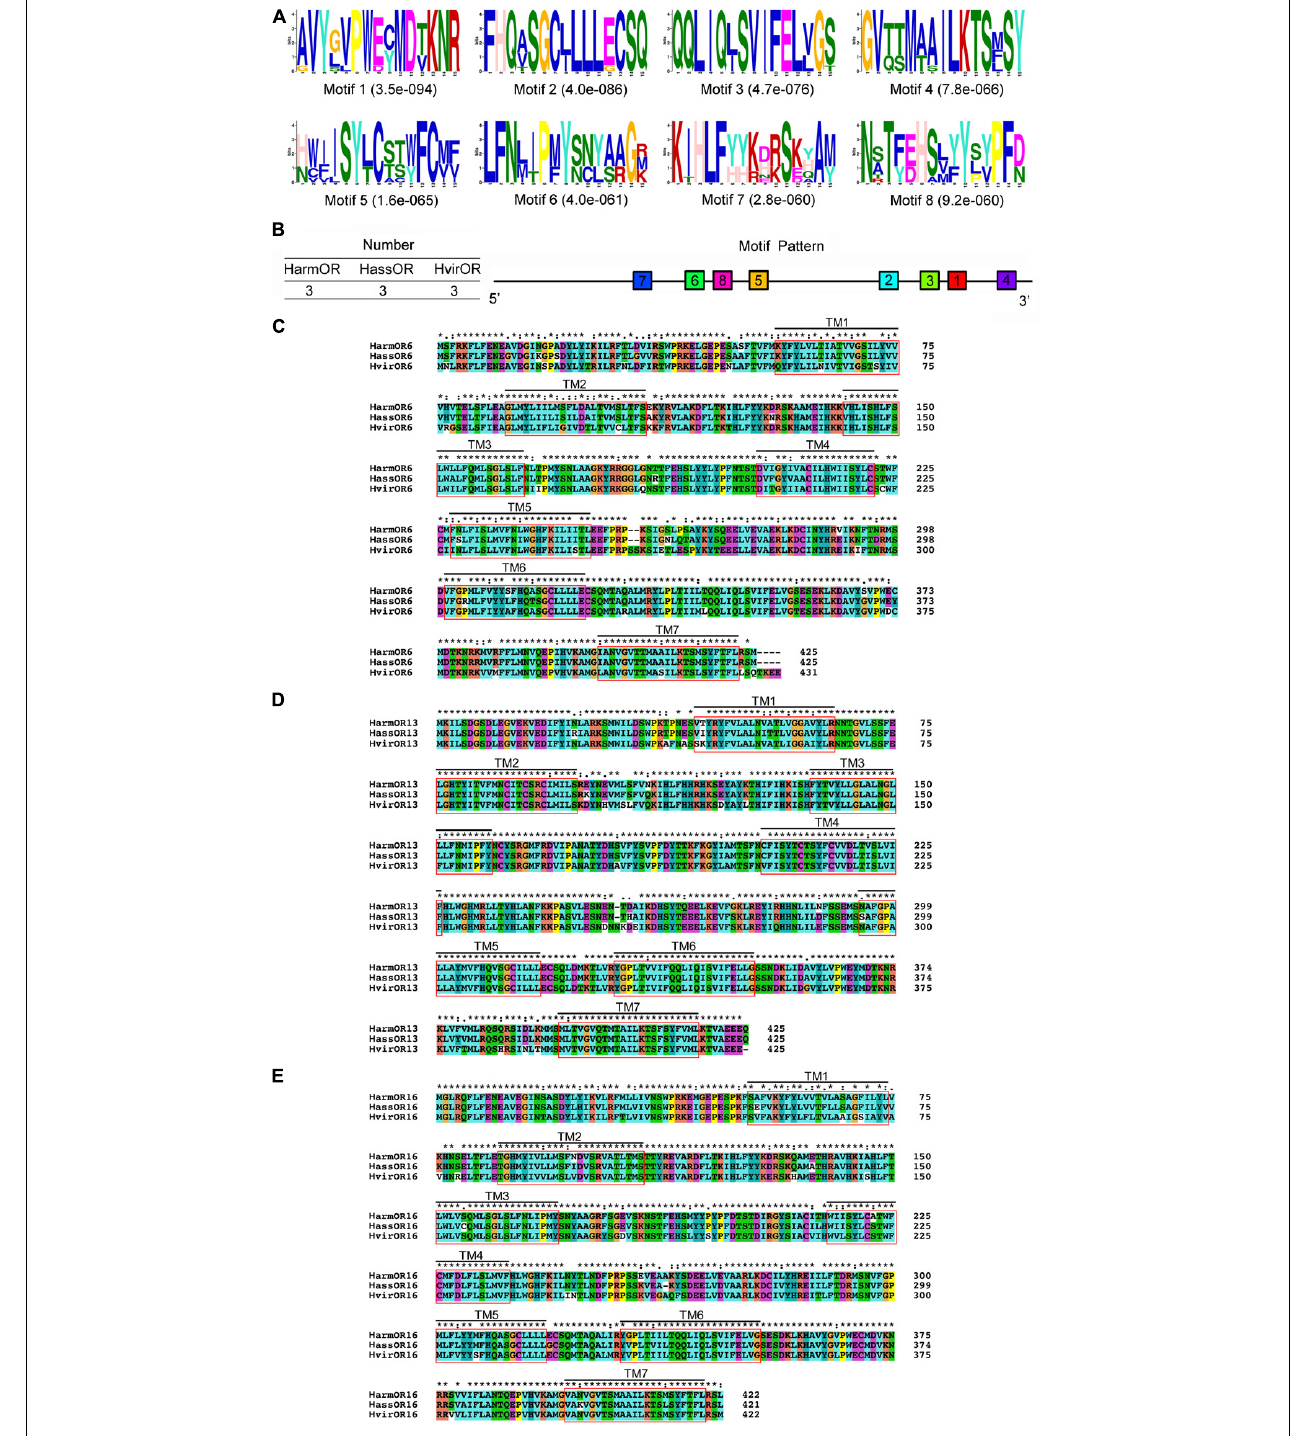
FIGURE 2 | Motif analysis of pheromone receptors (PRs) identified from three closely related Lepidoptera species, and the alignment of amino acid sequence of three set of PRs. (A) The eight motif-pattern discovered in nine PRs from Helicoverpa armigera , H. assulta, and Heliothis virescens . (B) The locations of each motif-pattern on the predicted protein sequence from N-terminal to C-terminal. Smaller numbers indicate higher conservation. (C) The alignment of amino acid sequence of clade OR6 from H. armigera , H. assulta , and H. virescens . TM1-TM7 indicates seven transmembrane domains. Harm: H. armigera ; Hass: H. assulta ; Hvir: H. virescens . (D) The alignment of amino acid sequence of clade OR13 from H. armigera , H. assulta , and H. virescens . (E) The alignment of amino acid sequence of clade OR16 from H. armigera , H. assulta , and H. virescens .